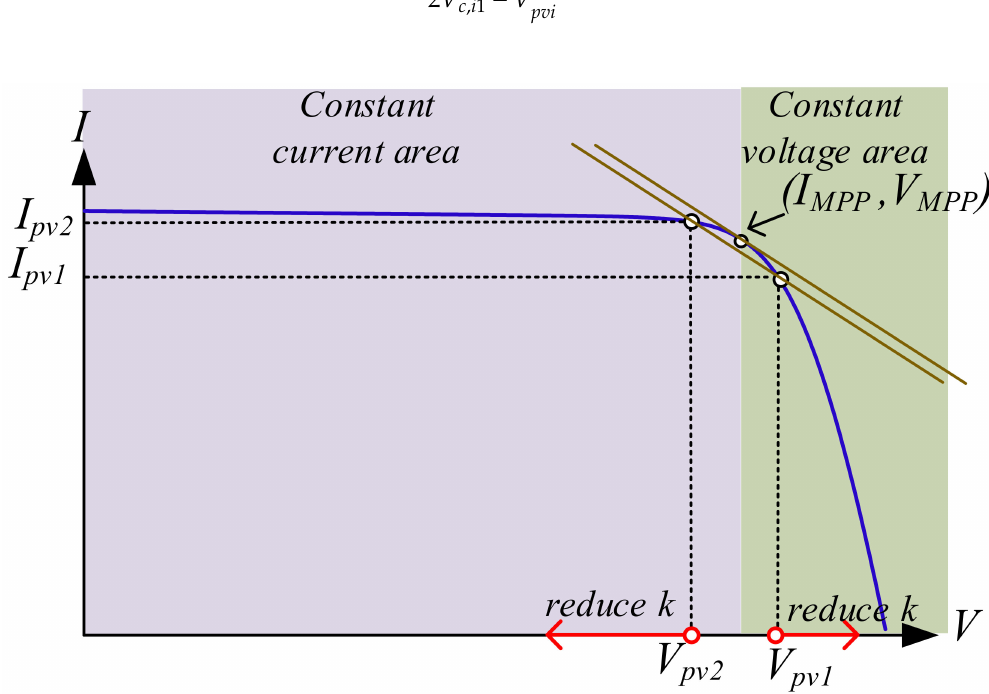
Figure 8. Relationship between operating points of two strings and V MPP on I-V curve.